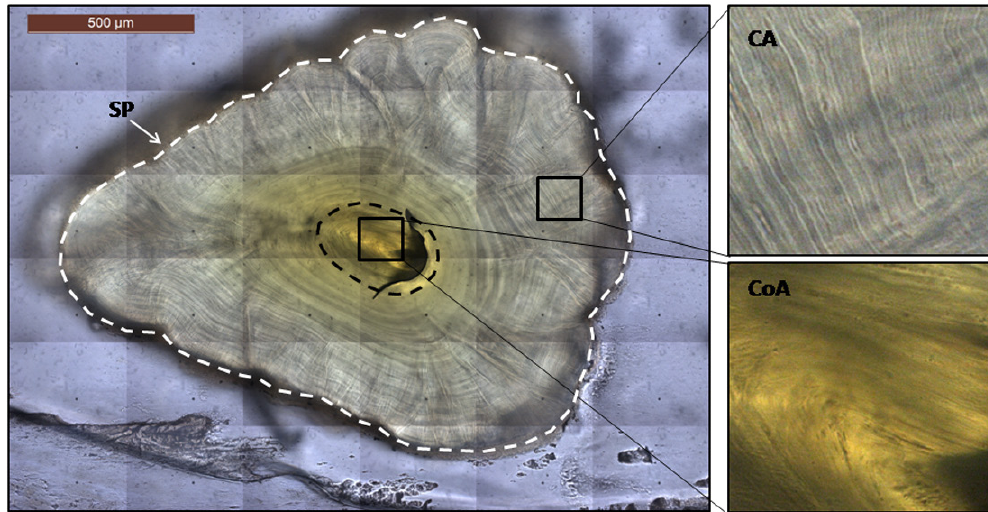
Fig. 2. – Composite image of an Eledone cirrhosa stylet preparation, showing the counted area (CA, the area between dashed lines), in which growth rings are discernible, and the core area (CoA, the area within the dashed black line), where the growth rings appear obliterated. The number of growth rings in CoA was extrapolated following the deposition rate found in CA. Stylet perimeter (SP) is indicated by the white dashed